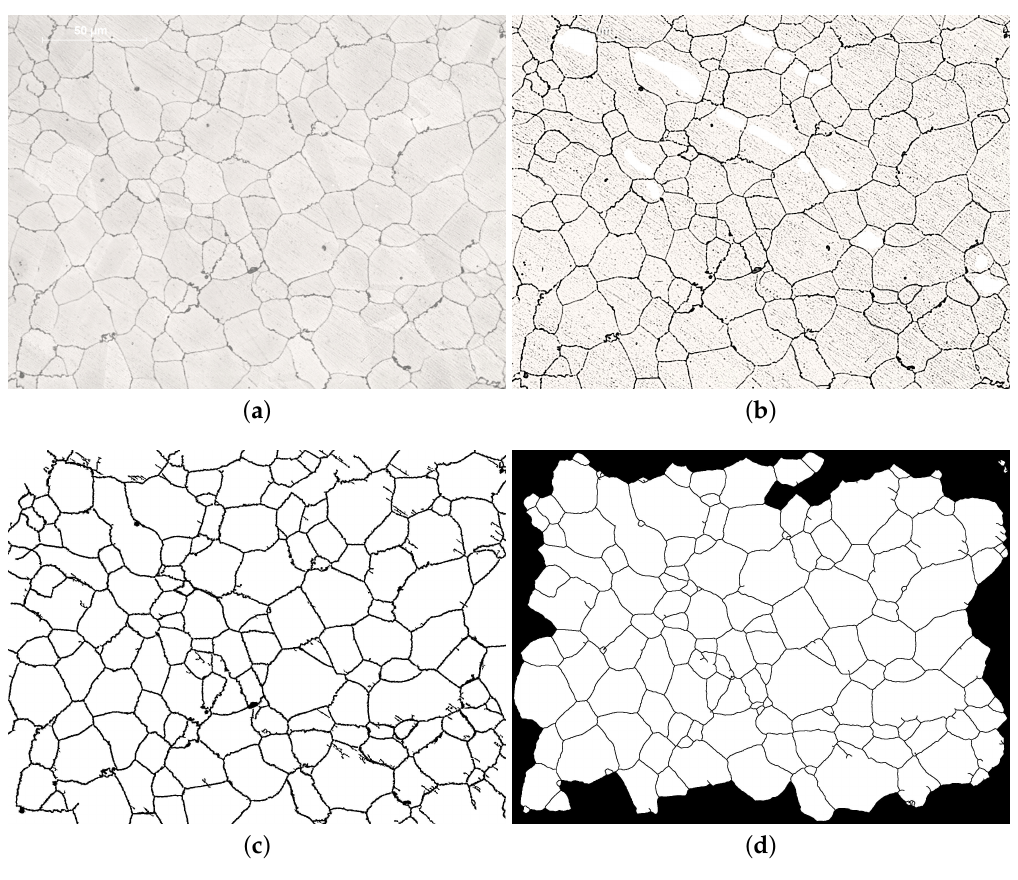
Figure 6. Semi-automated procedure to detect grains. ( a ) Original image; ( b ) Photo editor processed and scratches manual removal; ( c ) Binarization and black spots removal; ( d ) Border grains